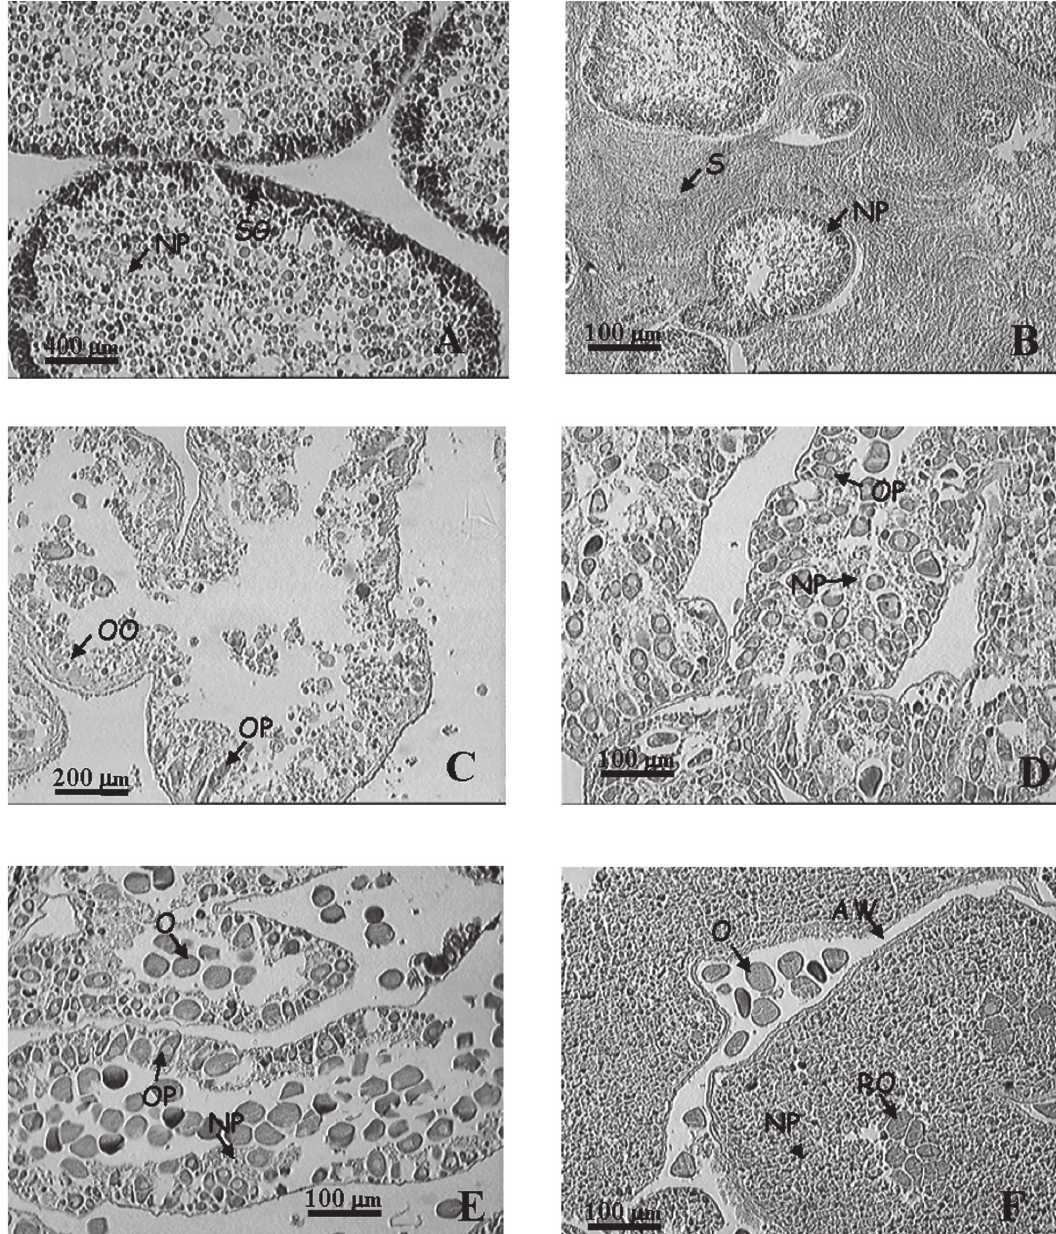
Fig . 2 . – histology of the gonads of Sphaerechinus granularis . Males: A M0, spent condition; B M1, mature gonad with sperm. Females: C , h1, spent condition; D , h2 phase of oocyte maturation; E , h3, mature state with ova; F , h4, phase of gonadal reconstitution with maximum thickness of the nutritive layer. aW, ascinal wall; nP, nutritive phagocytes; o, mature ova; oo, oogonia; oP, primary oocytes; ro, relict ova; s, spermatozoa; sG,